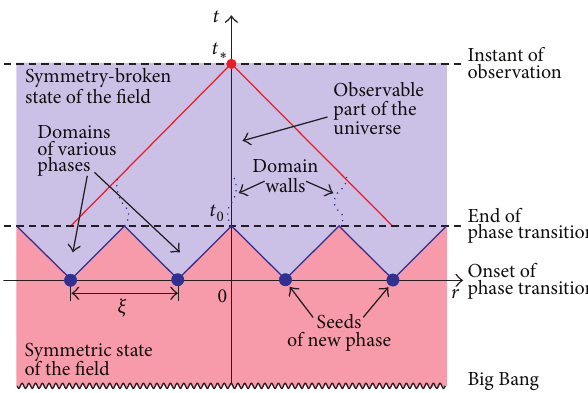
Figure 2: Sketch of development of the phase transition in the expanding